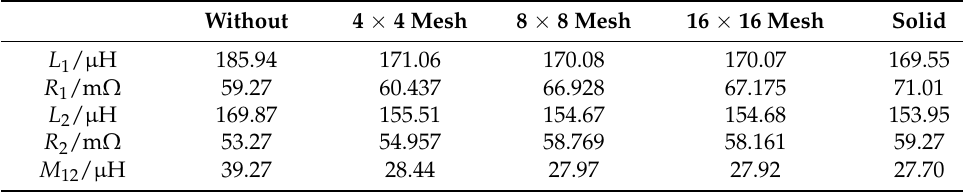
Table 1. System parameters without shielding plate and using four shielding plates.